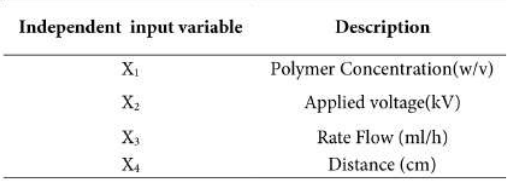
Table 1. list of input variable for